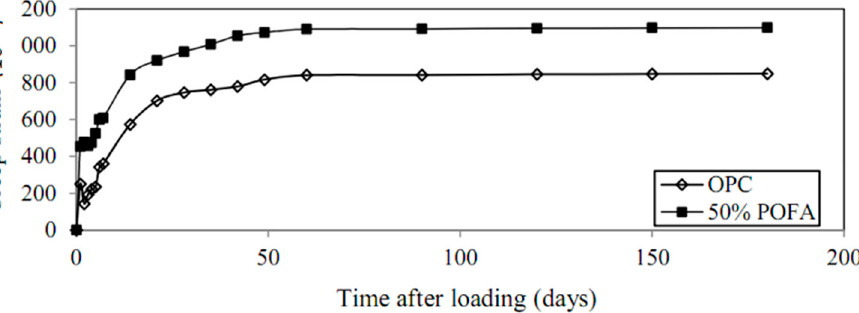
Figure 10. Creep strain vs. time after loading of POFA concrete incorporated with ground POFA [109]. Reprinted with permission from Trans Tech Publications [109].